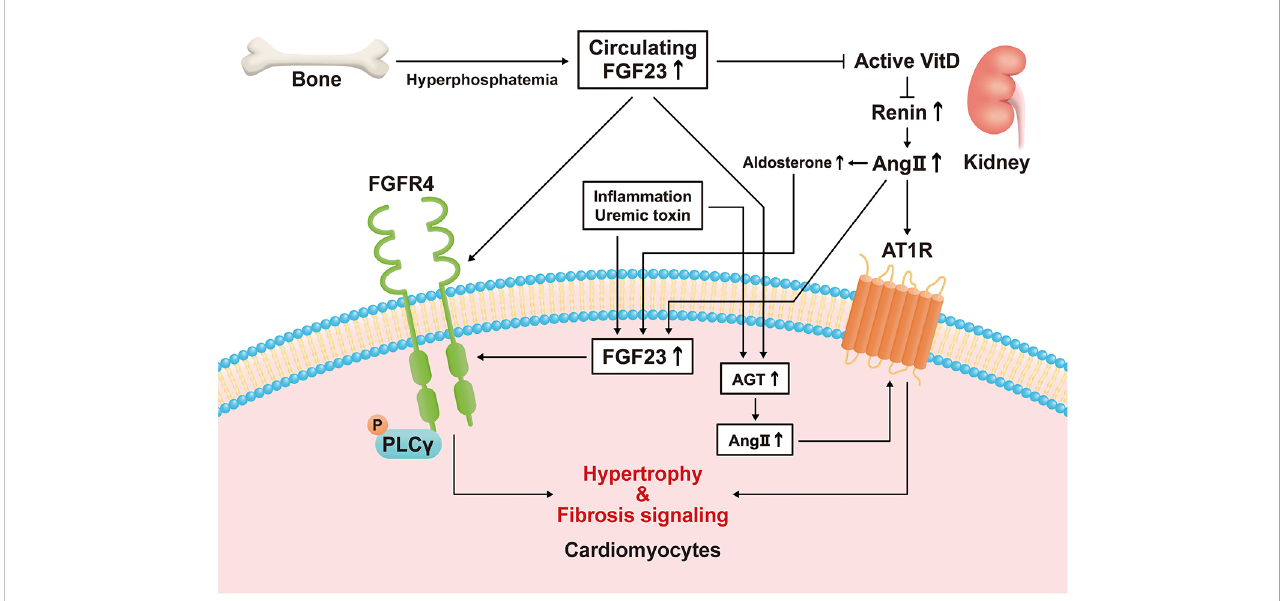
FIGURE 1 Direct and indirect mechanisms mediate the effects of fi broblast growth factor (FGF)23 on left ventricular hypertrophy. Hyperphosphatemia induces an increase in circulating FGF23 concentration by increasing its secretion by bone. FGF23 stimulates hypertrophic signaling via fi broblast growth factor receptor (FGFR)4 in cardiomyocytes. FGF23 also suppresses active vitamin D (VitD) synthesis in the kidney, and the activation of VitD is lower in a chronic kidney disease (CKD)-related milieu. Active VitD inhibits renin activity in the kidney and heart and increases serum angiotensin II (Ang II) concentration and its cardiac expression. Ang II binds to angiotensin II receptor type 1 (AT1R) in cardiomyocytes, causing cardiac hypertrophy and fi brosis. In fl ammatory cytokines, a uremic milieu, Ang II, and aldosterone induce FGF23 transcription in cardiomyocytes. Circulating FGF23 also causes an increase in local angiotensinogen and Ang II expression in cardiomyocytes, leading to hypertrophy and fi